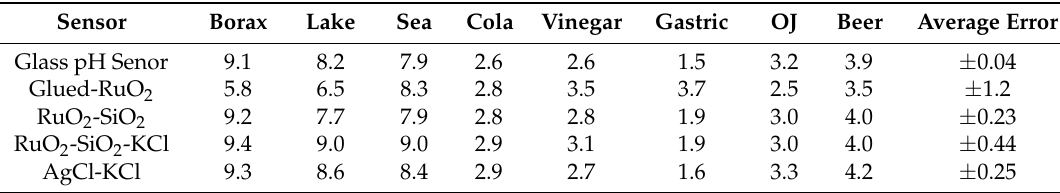
Table 5. Summary of pH measurements using the developed pH sensors and comparison to a commercial glass pH